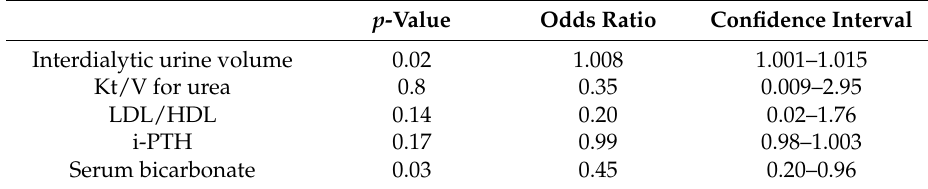
Table 2. Cox-regression analysis for the prevalence of serum bicarbonate levels and interdialytic urine volume on the manifestation of peripheral vascular disease.